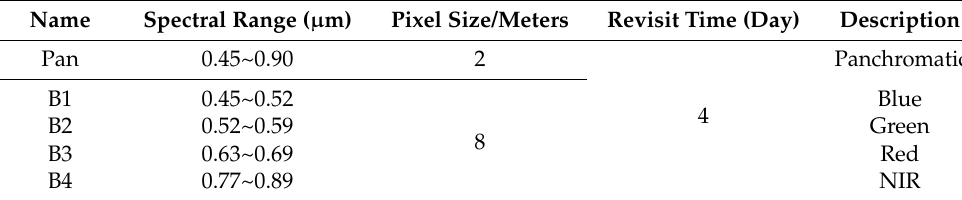
Table 1. Main parameters of the GF-1 PMS sensor.